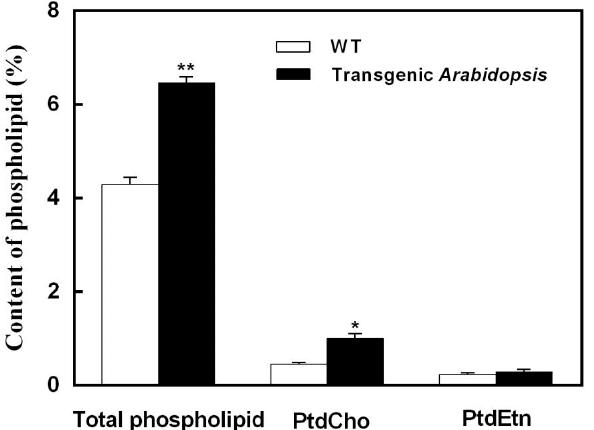
Figure 12. Contents of total phospholipids, phosphatidylcholine (PtdCho), and phosphatidylethan- olamine (PtdEtn) in seeds of wild type (WT) and transgenic plants of Arabidopsis thaliana with GmPLMT . Symbols “*” and “**” indicate significant differences at p values of 0.05 and 0.01, respec-